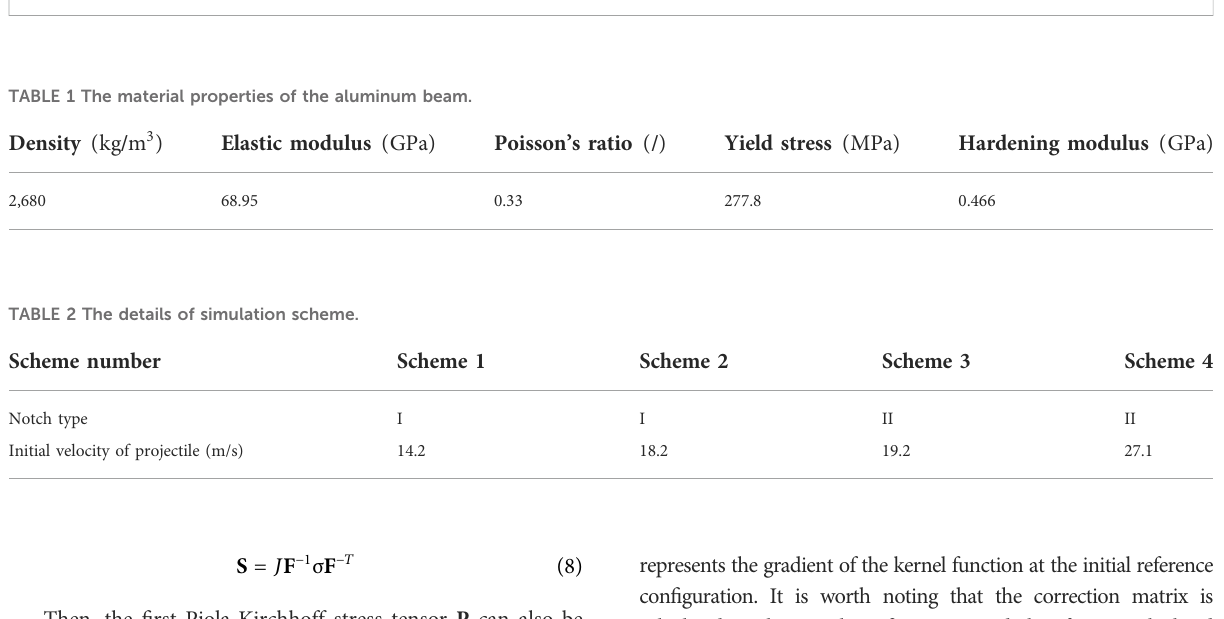
Comparison of present simulation (third column) with the experimental ( fi rst column) (Chen and Yu, 2004) and simulation (second column) (Islam and Peng, 2019) results of (A) Scheme 1, (B) Scheme 2, (C) Scheme 3 and (D) Scheme 4.